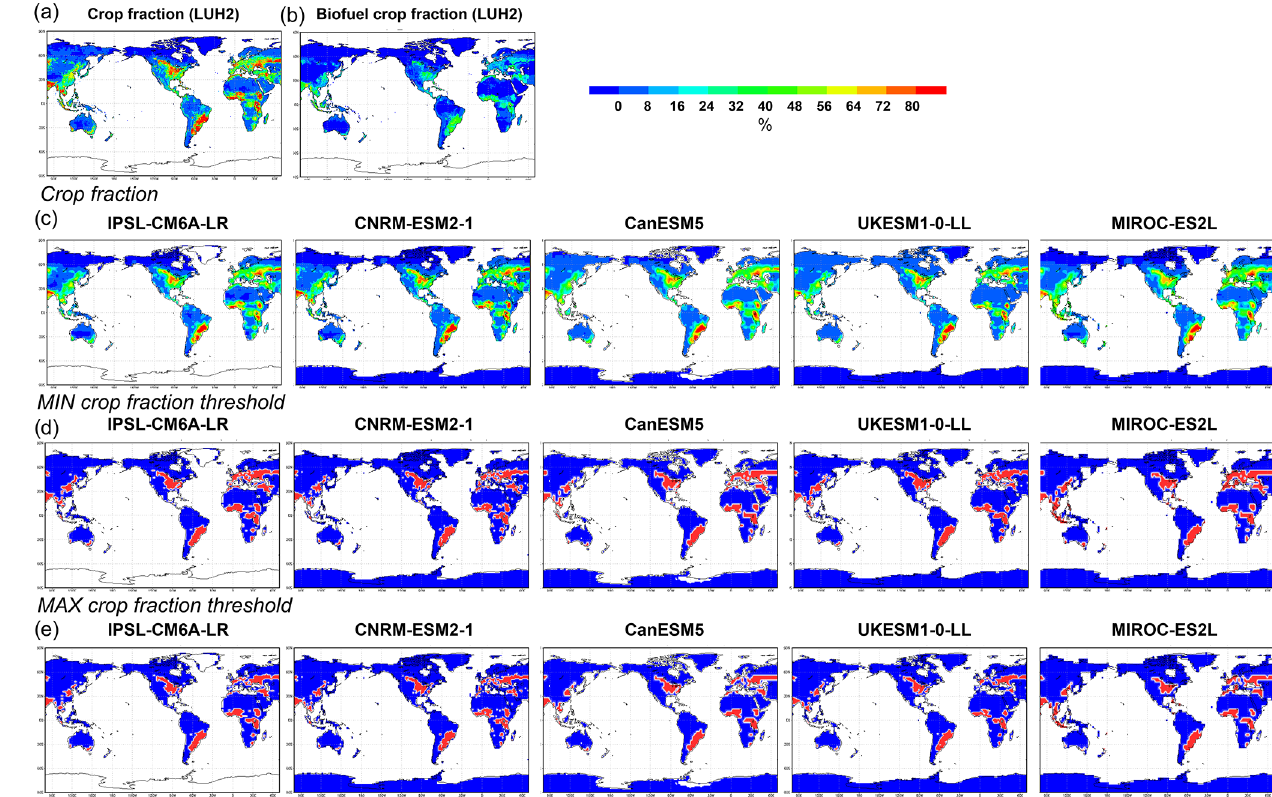
Figure A3. Spatial variation of (a) grid cropland fraction (b) and second-generation bioenergy cropland fraction by LUH2. Panel (c) shows the spatial variation of grid cropland fraction estimated by CMIP6 ESMs. The spatial variation of the selected (d) minimum and (e) maximum thresholds (which intersect at least once either the global cropland area estimated by ESM itself or LUH2 data set from 2015 to 2100 as shown in Fig. A1) for estimating crop-concentrated grids in